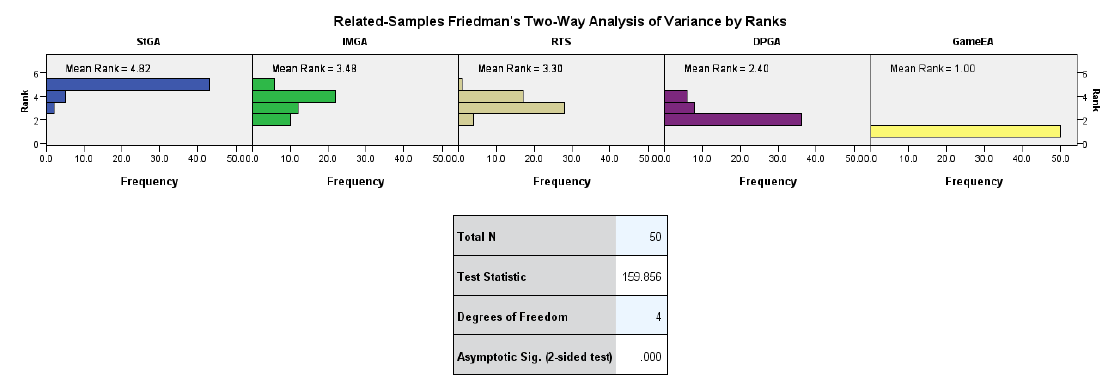
Figure 1. Related samples test view.